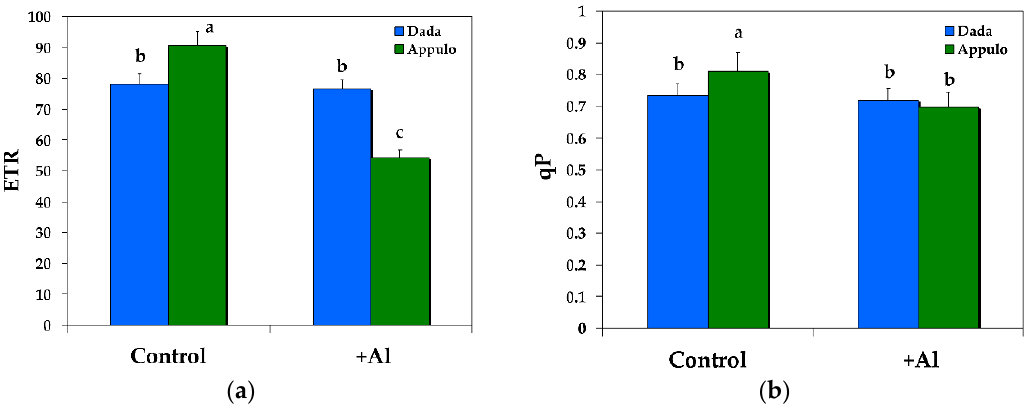
Figure 4. Changes in the relative PSII electron transport rate (ETR) ( a ); and changes in the photochemical fluorescence quenching, that is the relative reduction state of Q A , reflecting the fraction of open PSII reaction centers ( q P ) ( b ); in the triticale ‘Dada’ and the durum wheat ‘Appulo E’, under normal growth conditions (control) and under Al 3+ exposure (+Al). Error bars on columns are standard deviations based on five leaves from five plants. Columns with different letters are statistically different ( p < 0.05).